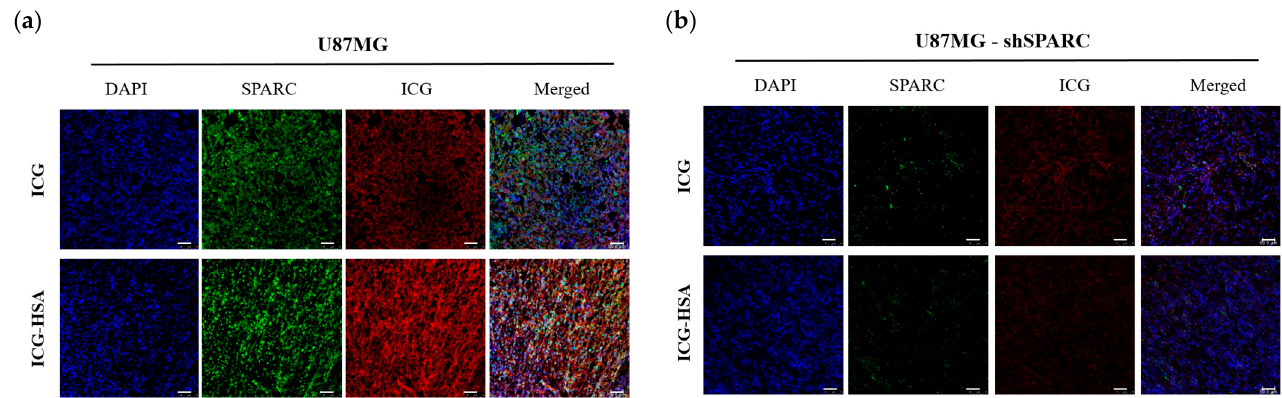
Figure 5. Fluorescence imaging of ICG-HSA complex in tumor tissue. Confocal images of SPARC obtained through immunofluorescence staining and injected ICG were confirmed in frozen tumor sections. ( a ) Fluorescence images in the U87MG; ( b ) U87MG-shSPARC tumor. Scale bars, 50 µ